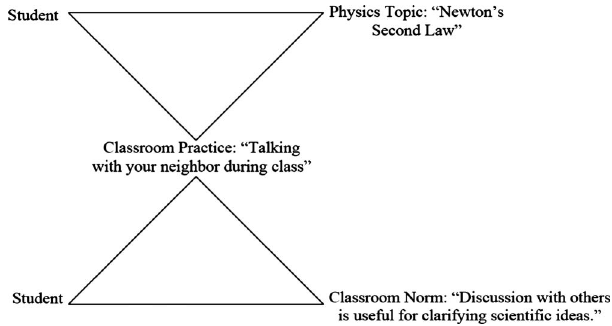
FIG. 1. Mediation of student learning by